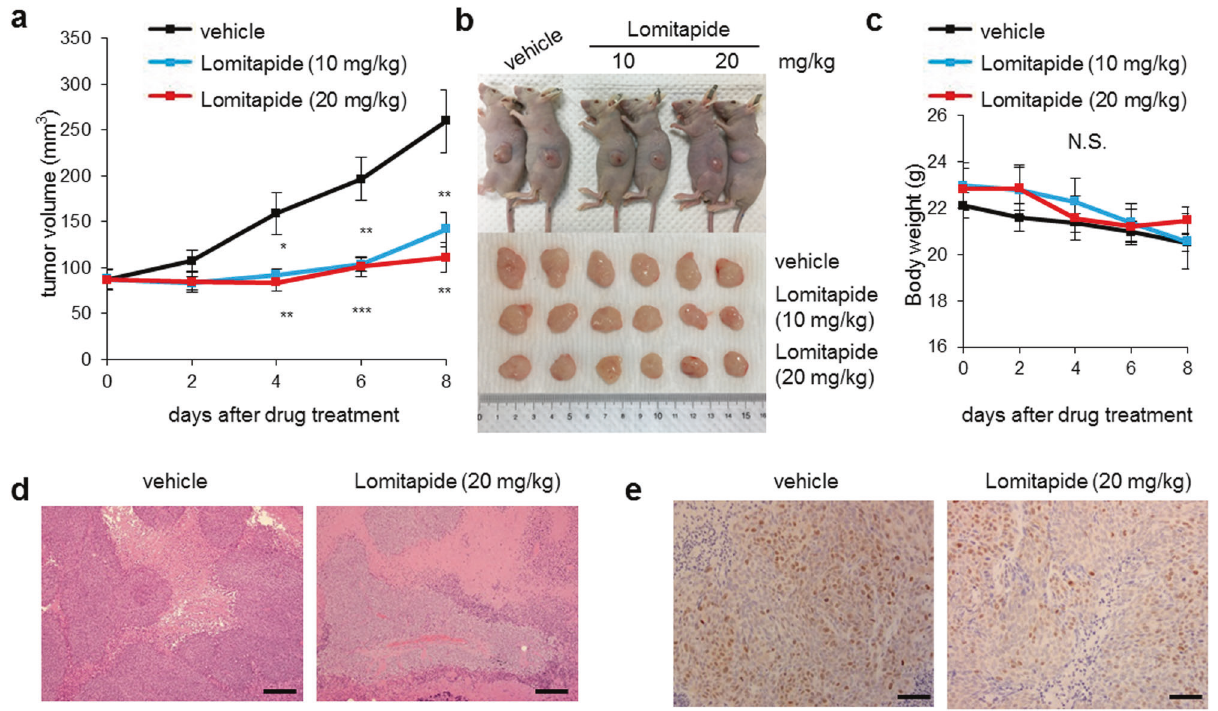
Fig. 4 Lomitapide suppresses the growth of tumor xenografts. a HT29 cells were inoculated into fl anks of nude mice and tumor volumes were measured for 10 days after intraperitoneal injection into xenograft tumors every 2 days. b Representative images of xenograft tumors at the day of sacri fi ce. c Body weight of xenograft mice bearing HT29 tumors during the in vivo experiment. Data were expressed as means ± SEM (* P < 0.05; ** P < 0.01; *** P < 0.001, Student ’ s t -test). ( n = 6 per group). d Hematoxylin and eosin (H&E) staining of tumor tissues collected from either vehicle or lomitapide-treated mice. e Tumor tissues were subjected to immunohistochemistry staining with Ki67 antibodies. Scale bar: 20 μ